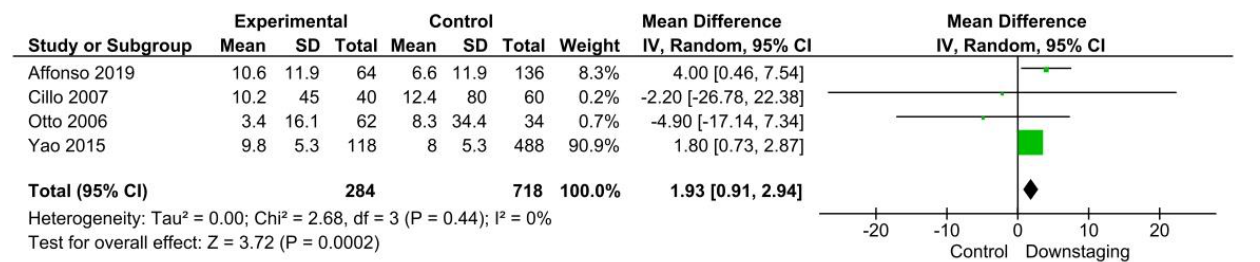
Figure 3. Question 1: Forrest plot on time to liver transplantation.